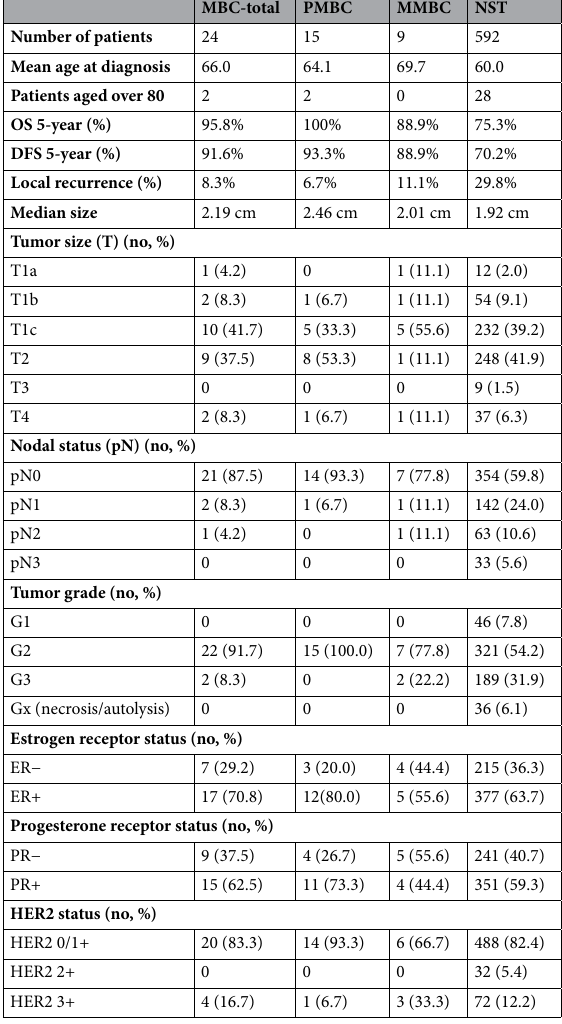
Table 2. Comparison of pure and mixed mucinous breast cancer with NST cancer of the